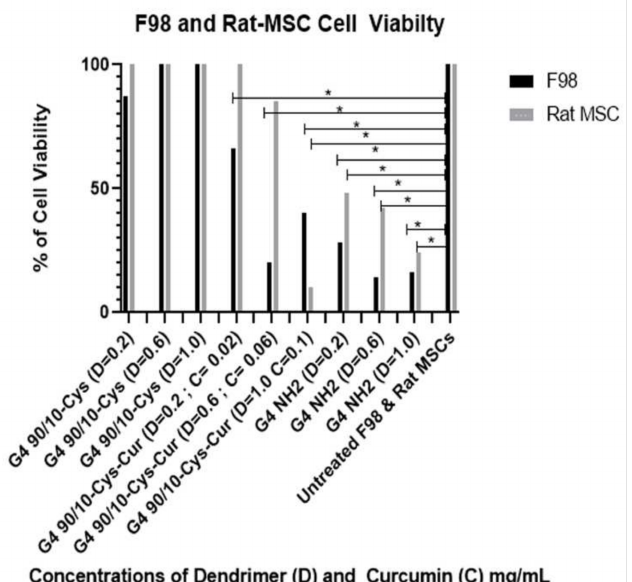
Figure 9. Viability of F98 and non-cancerous rat MSCs after 24 h treatment with G4 90/10-Cys, G4 90/10-Cys-Cur, and G4 NH2. For F98: G4 90/10-Cys there was no loss of cell viability and increased cell viability at the dose of 1.0 mg/mL. For G4 90/10-Cys; D = 0.02 mg/mL, p = 0.94, D = 0.47, p = 0.017. D = 1.0 mg/mL p = 0.0001. For G4 90/10-Cys-Cur p < 0.0001 for all three doses. For the cell treated with NH 2 , cell viability was significantly lost at every dose; D = 0.02 mg/mL, p = 0.0019, D = 0.06 mg/mL, p = 0.0001, D = 1.0 mg/mL, p = 0.0001. * p <